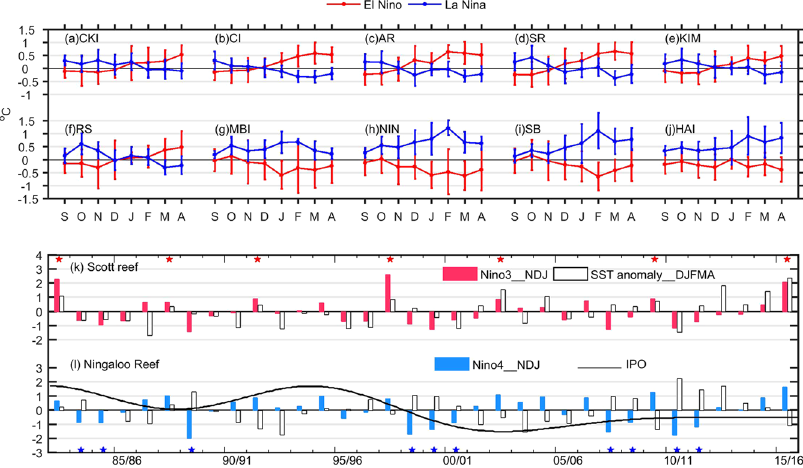
Figure 2. ( a – j ) Composite SST anomalies during El Niño and La Niña events at ten selected reefs. The error bars denote 95% confidence intervals. ( k ) Time series of standardised SST anomaly averaged in extended summer months (December-April) at the Scott reef and standardised November-January averaged Niño 3 index; ( l ) time series of standardised SST anomaly averaged in extended summer months (December-April) at the Ningaloo reef, standardised Niño4 index and IPO index. The red (blue) stars in ( k , l ) denote the developing years of El Niño (La Niña). Figures are plotted using MATLAB R2015b